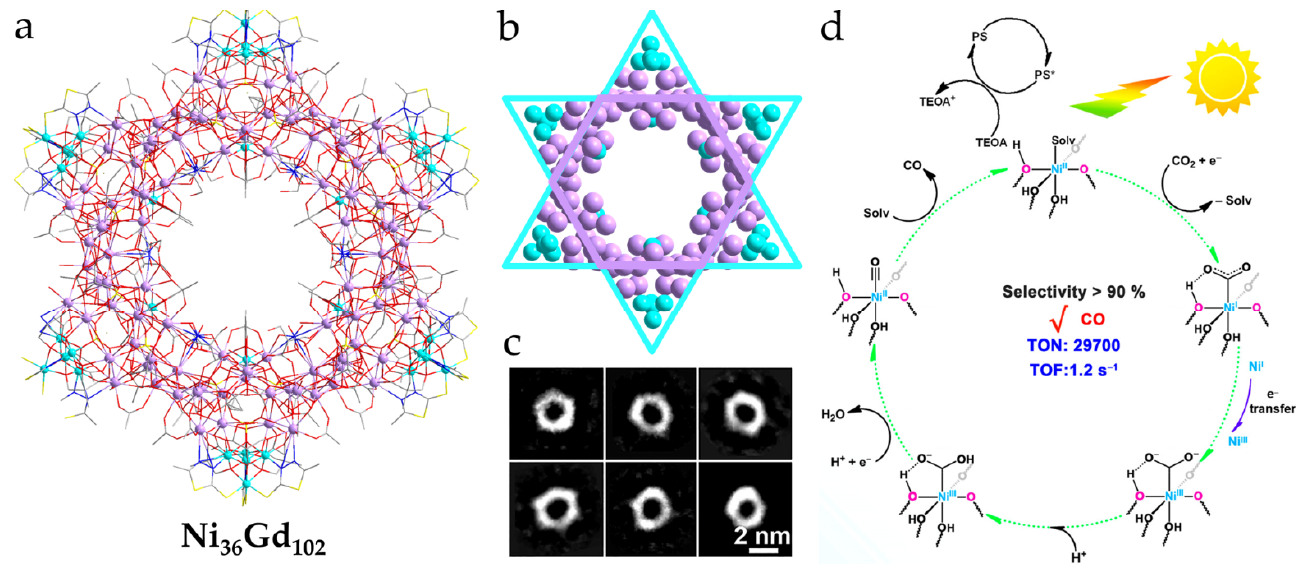
Figure 5. ( a ) The structures of the 3 d -4 f cluster Ni 36 Gd 102 . ( b ) The “star-of-David”-like cluster core. ( c ) The high-resolution TEM images of Ni 36 Gd 102 . ( d ) The CO 2 reduction mechanism. Color legends: Ln, lavender; Ni, turquoise; O, red; C, gray; N, blue; S, yellow. Adapted with permission from Ref. [26]. Copyright 2020, American Chemical Society.